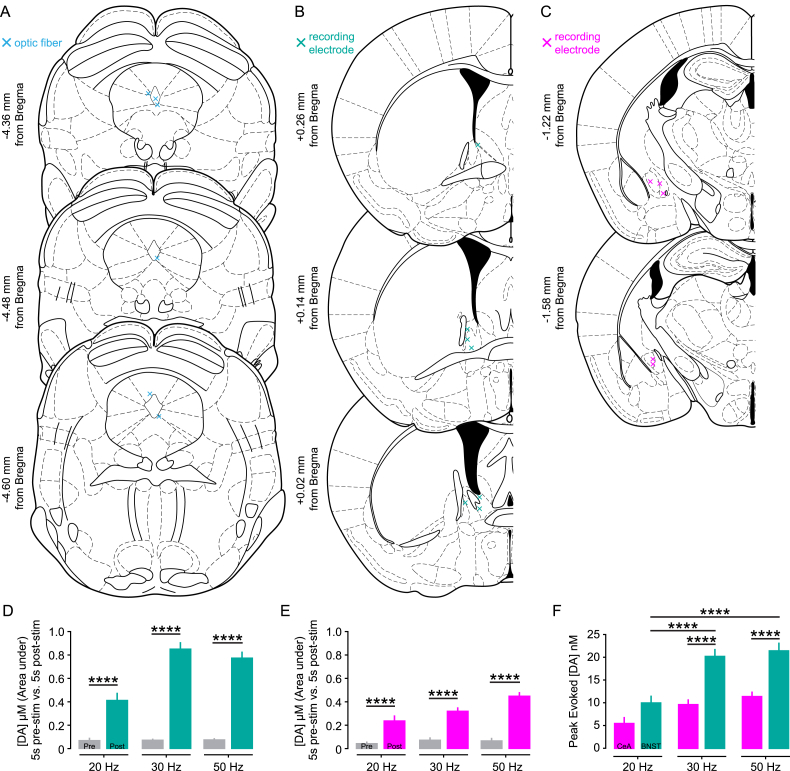
Placement of Optic Fiber Tip and Recording Sites for In Vivo FSCV and Evoked DA Release at Different Stimulation Frequencies, Related to Figure 3(A) The position of the optic fiber tip (blue cross) in the DRN and (B) the recording electrode in the BNST (teal cross) and (C) CeA (magenta cross) of TH::Cre mice used for in vivo FSCV recordings.(D–E) Extracellular DA concentration ([DA]), evoked by 150 pulses of blue light (5 ms duration) at 20, 30, and 50 Hz, was quantified by calculating the area under each trace during the time window 5 s prior to stimulation onset compared to the time window 5 s post-stimulation onset. (D) Optical stimulation of DRN DA neurons evoked a significant increase in [DA] in the BNST compared to pre-stimulation levels at 20 Hz (paired t test: t44 = 5.761, ∗∗∗∗p < 0.0001), 30 Hz (paired t test: t106 = 13.74, ∗∗∗∗p < 0.0001), and 50 Hz (paired t test; t105 = 13.57, ∗∗∗∗p < 0.0001). (E) Optical stimulation of DRN DA neurons evoked a significant increase in [DA] in the CeA compared to pre-stimulation levels at 20 Hz (paired t test: t51 = 4.914, ∗∗∗∗p < 0.0001), 30 Hz (paired t test: t70 = 9.911, ∗∗∗∗p < 0.0001), and 50 Hz (paired t test: t65 = 10.64, ∗∗∗∗p < 0.0001).(F) As a group, peak [DA] was increased in a frequency-dependent manner (two-way ANOVA: F2,441 = 22.19, ∗∗∗∗p < 0.0001). In the BNST, peak [DA] evoked by 30 Hz and 50 Hz stimulation was greater than that evoked by 20 Hz (Bonferroni multiple comparisons: 20 Hz versus 30 Hz, ∗∗∗∗p < 0.0001; 20 Hz versus 50 Hz, ∗∗∗∗p < 0.0001; 30 Hz versus 50 Hz, p > 0.9999). In contrast, peak [DA] in the CeA did not differ significantly for different stimulation frequencies (Bonferroni multiple comparisons: 20 Hz versus 30 Hz, p = 0.7134; 20 Hz versus 50 Hz, p = 0.0806; 30 Hz versus 50 Hz, p > 0.9999). Peak-evoked [DA] was greater in the BNST compared to the CeA at 30 Hz (F1,441 = 54.39, ∗∗∗∗p < 0.0001; Bonferroni multiple comparisons: ∗∗∗∗p < 0.0001) and 50 Hz (Bonferroni multiple comparisons: ∗∗∗∗p < 0.0001).Data are represented as mean + SEM.